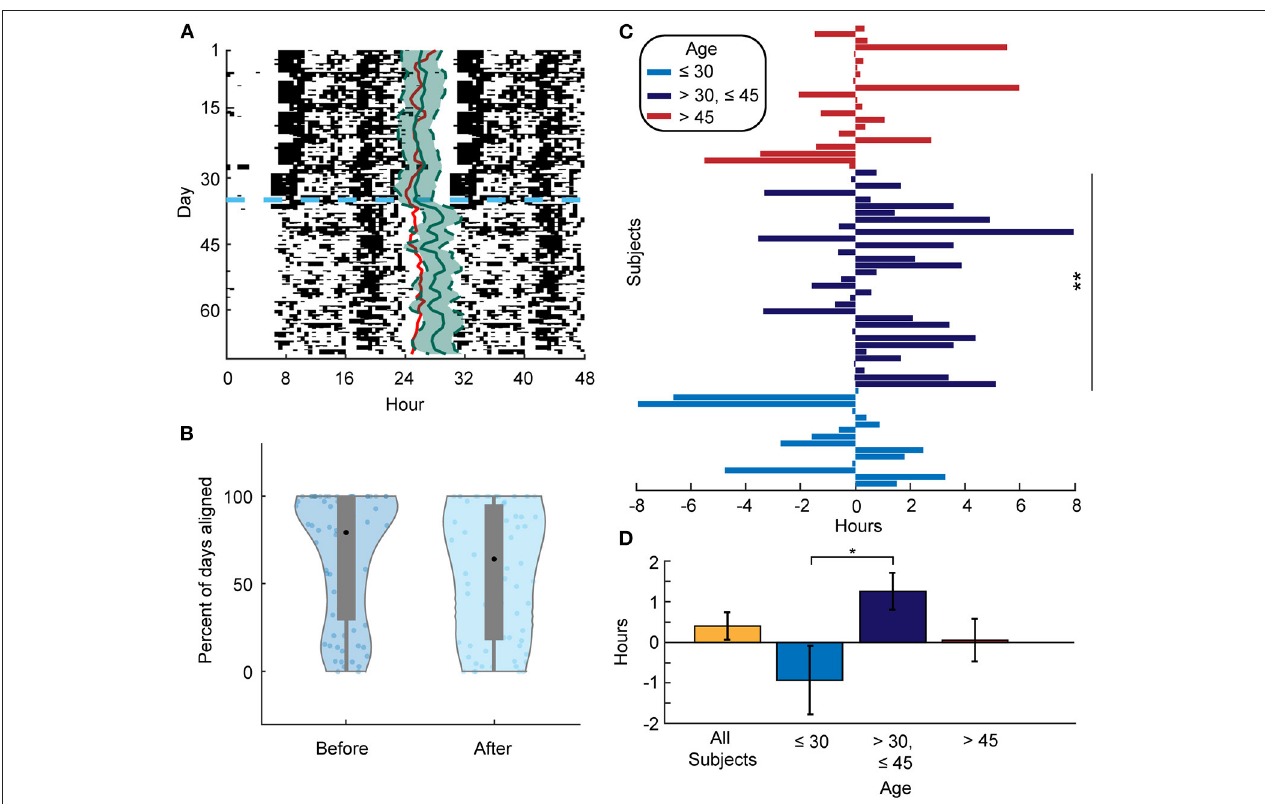
FIGURE 4 | (A) Actogram for a selected individual. The red line represents the DLMO phase prediction from the limit-cycle oscillator model, and the horizontal dashed blue line denotes the date of social distancing onset. Estimated CRHR phase (solid green line) with 80% confidence interval (dashed green line) is overlaid on daily activity patterns. As in Figure 1 , CRHR phases were shifted by − 4.4h to adjust for the mean difference between DLMO and CRHR. (B) Violin plots showing the distribution of the percent of days that an individual’s DLMO estimate was within the heart rate phase estimate + /– the 80% confidence interval both before (left) and after (right) social distancing. The mean percentage before is 78.08 and 69.39% after ( p = 0.002). (C) Phase differences for all subjects from before and after social distancing centered for each individual at the mean phase in the 35 days before social distancing. A positive (negative) value means that the mean phase after social distancing was later (earlier) than the mean phase before for that individual. Subjects between 30 and 45 years of age had a significant phase shift later ( p = 0.0089). **means p -value ≤ 0.01. (D) Mean phase difference (phase estimate after social distancing–phase estimate before social distancing) for the respective population (All subjects: 0.25 + /– 0.34h, < 30 years of age: − 0.93 + /– 0.85h, 30–45 years of age: 1.26 + /– 0.45h, and > 45 years of age: 0.05 + /– 0.53h). The phase differences of the under 30 and the between 30 and 45 years of age groups are significantly different ( p = 0.016). *denotes level 0.05 of statistical